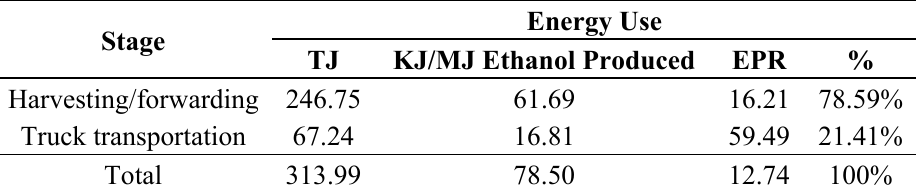
Table 7. Energy for harvesting and truck transportation stages.